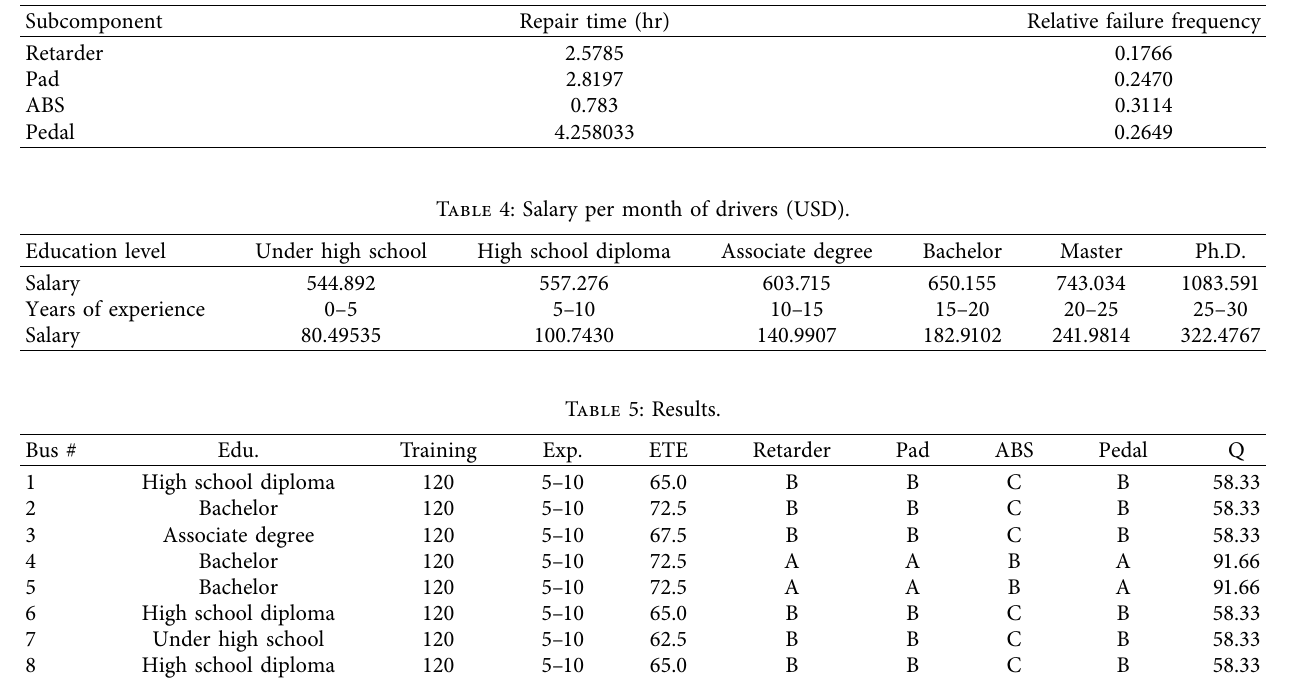
Table 3: Repair times and relative failure frequencies.